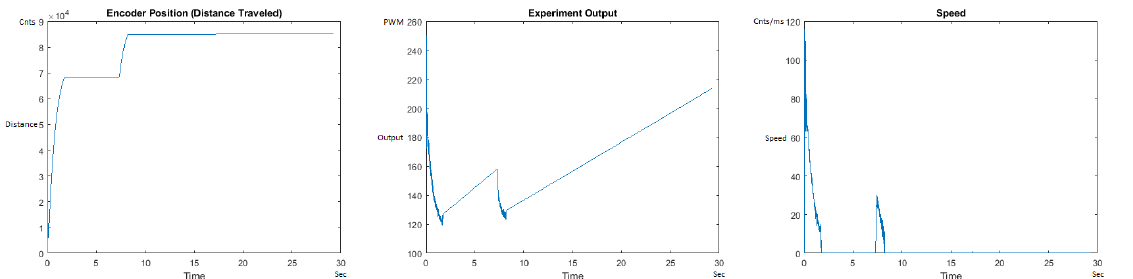
Figure 35. Encoder position, output and speed plots for basic PID UP operation—10 g.